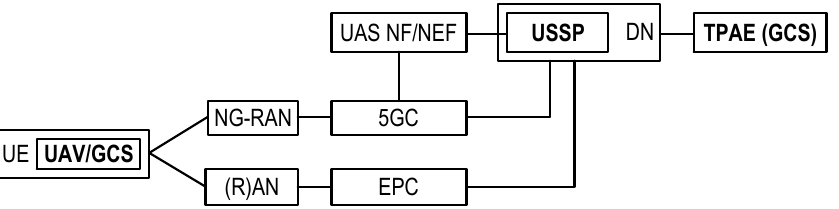
Figure 4. 3GPP framework for 4G/5G integration with UAS (based on [39]).